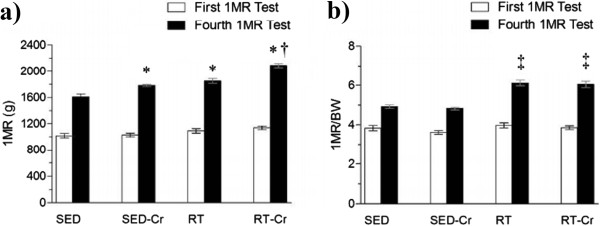
Maximum strength gain after 8 weeks of intervention. a) Absolute maximum strength gain related to the first to fourth tests of One Maximum Repetition (1MR); b) Relative maximum strength gain related to the first to fourth tests of One Maximum Repetition (1MR). Values in mean ± SD; n = 10 for all groups. SED, sedentary rats; SED-Cr, sedentary supplemented with creatine rats; RT, resistance training rats; RT-Cr, resistance training supplemented with creatine rats. Two way ANOVA, followed by the post hoc test of Student Newman-Keuls. *P < 0.001 vs. SED; †P < 0.001 vs. SED-Cr, RT; ‡P < 0.05 vs. SED, SED-Cr.